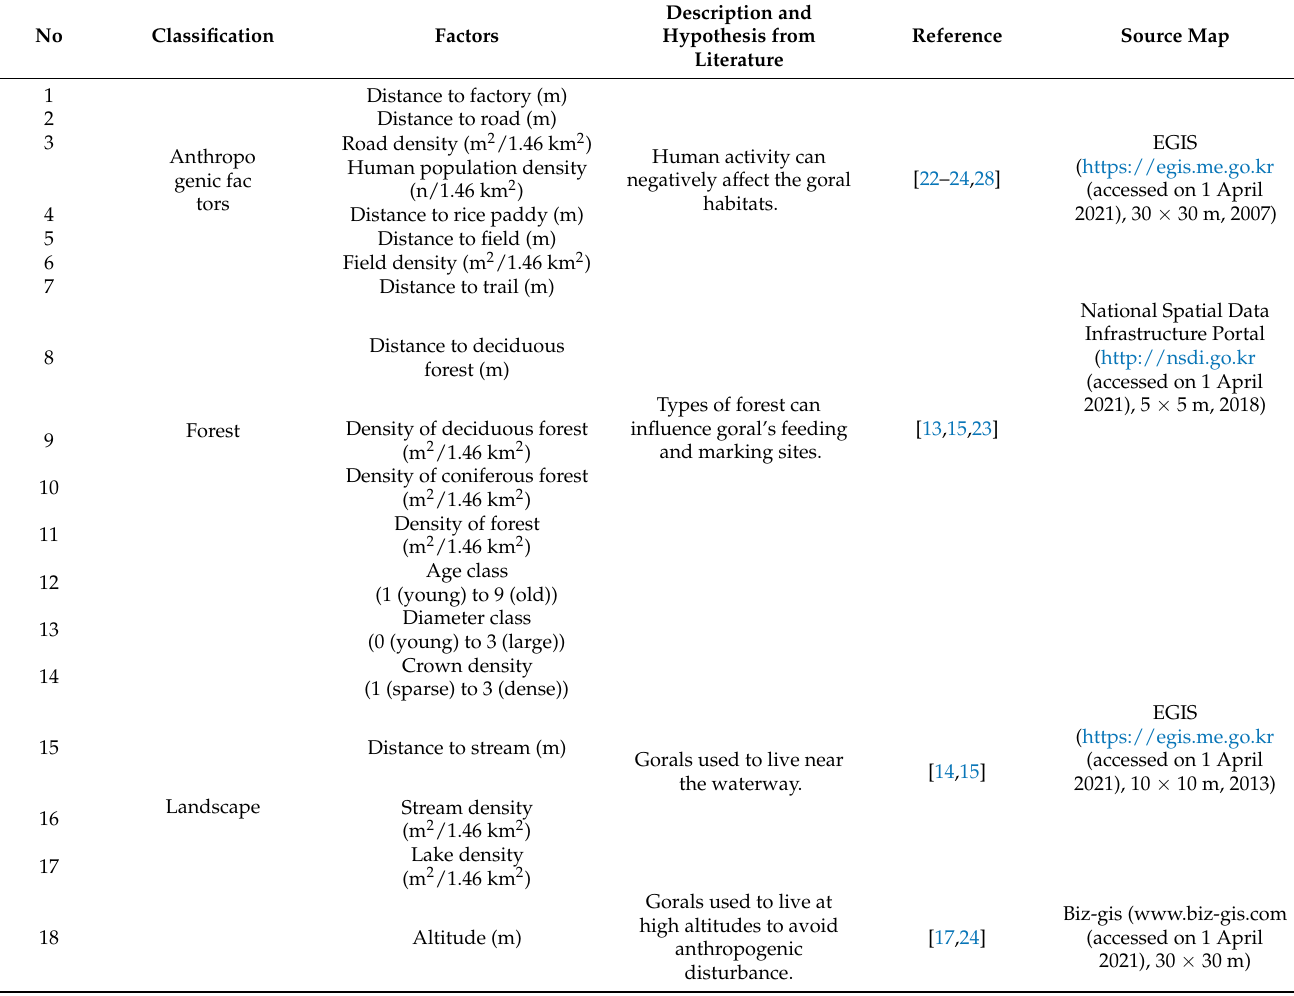
Table 1. Description, abbreviation, related references, and source map (website, resolution, and making year) of the 27 selected